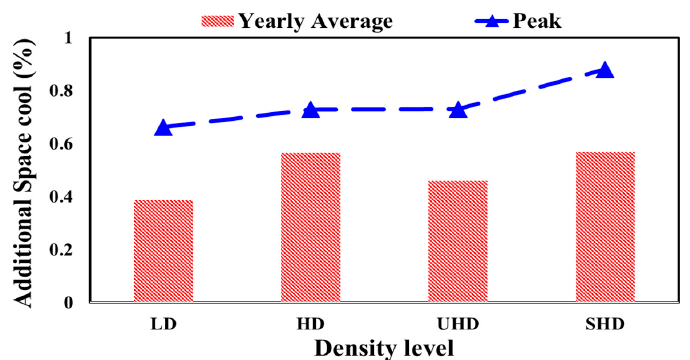
Figure 4. Yearly average and peak additional space cooling percentages employing dry variable thermal conductivity as compared with constant value at different density levels in the hot climate of UAE.